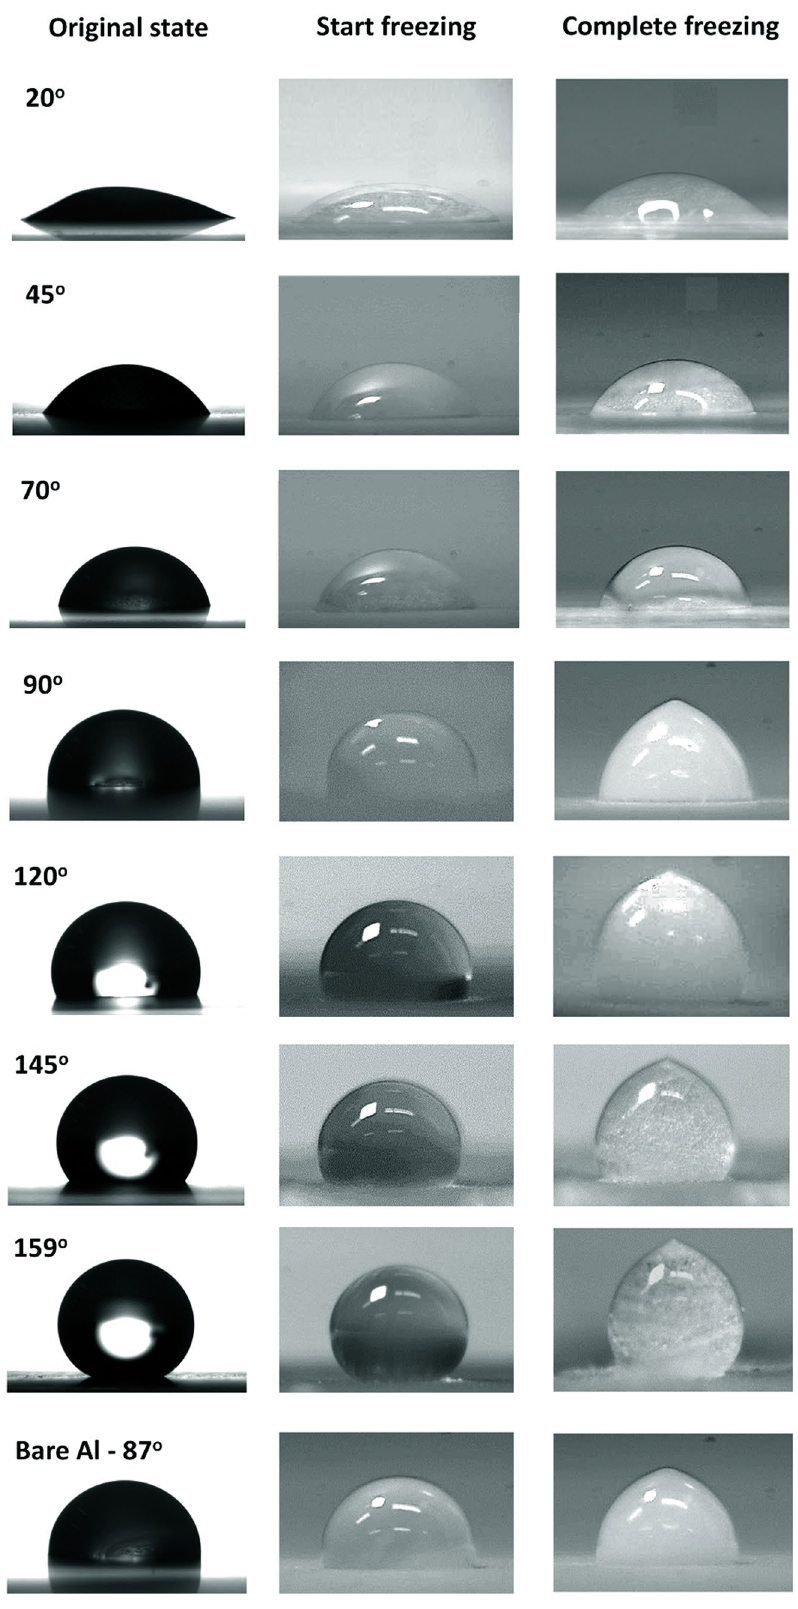
Figure 1. The original version of Figure